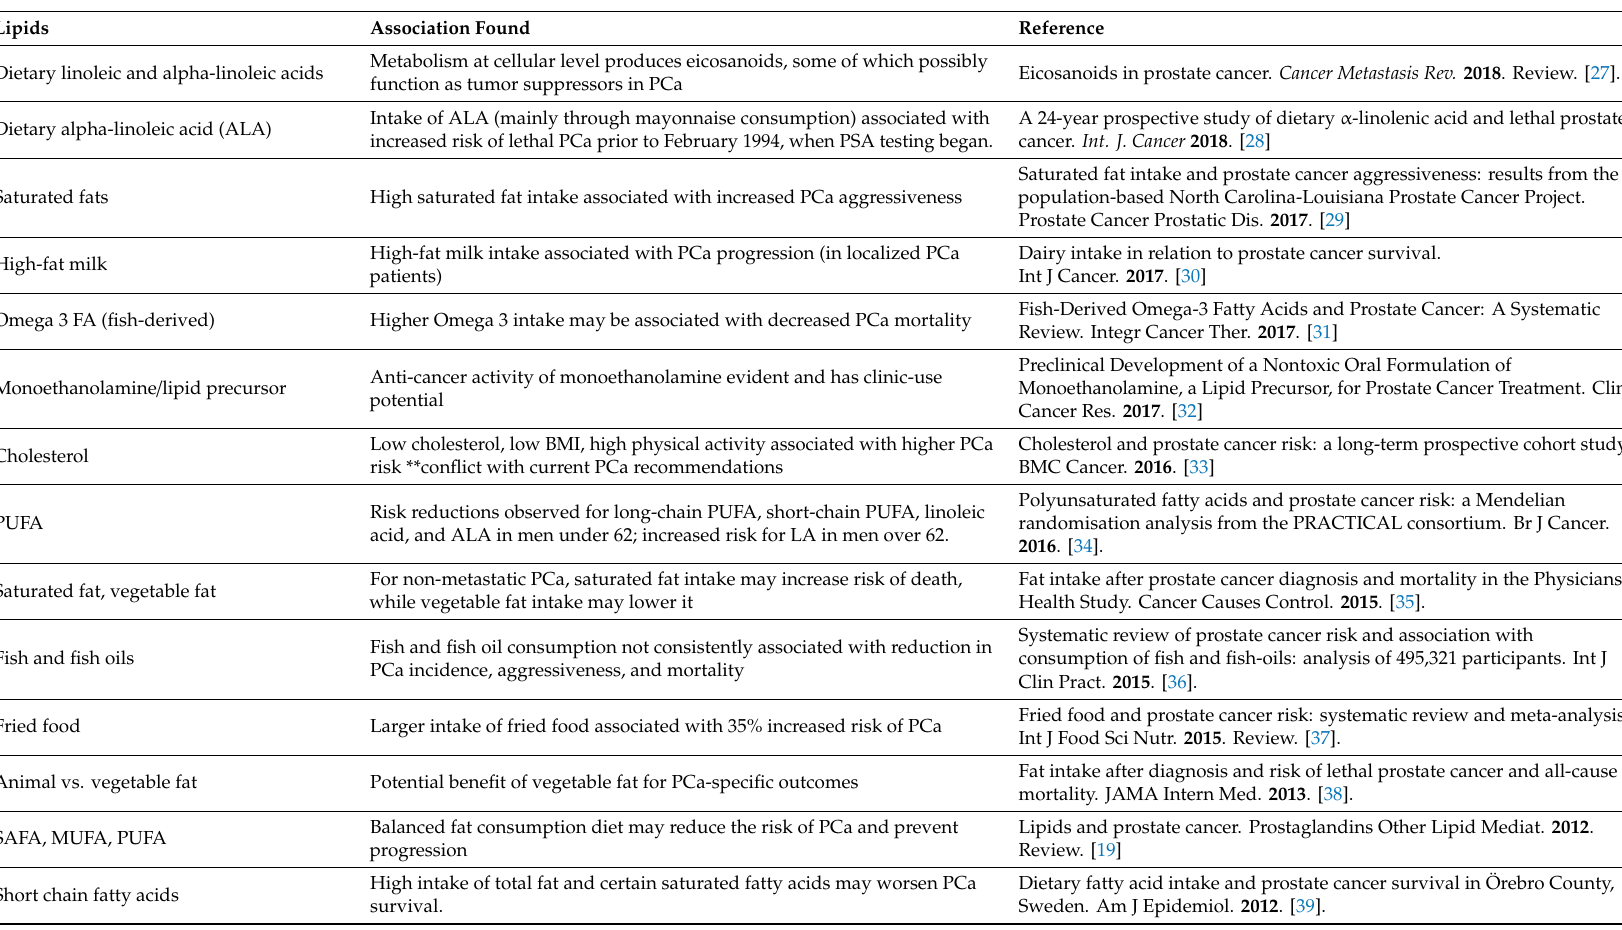
Table 1. Representative studies of associations between dietary lipids and prostate cancer